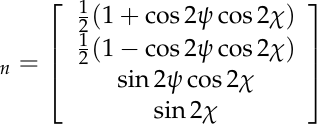
Table 1. Modified Stokes vectors for various polarizations.